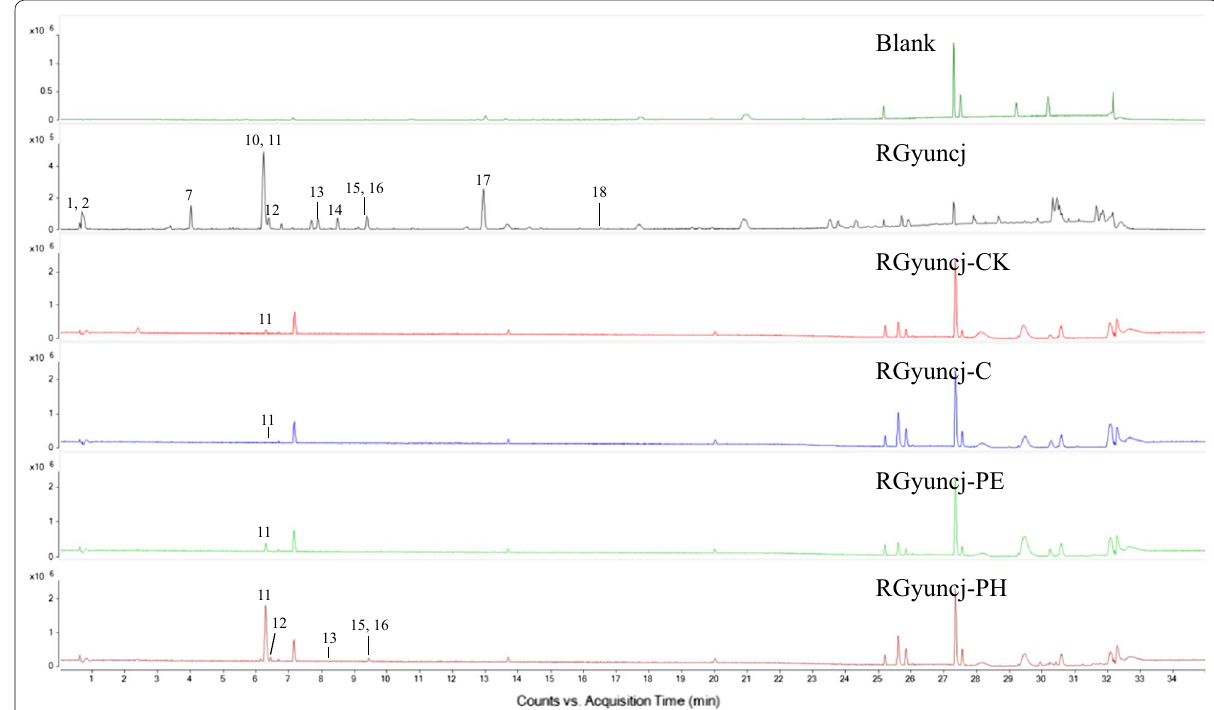
Fig. 3 Representative UPLC-Q/TOF–MS base peak chromatograms of medicinal material sample and various tissues from Cinnamomum